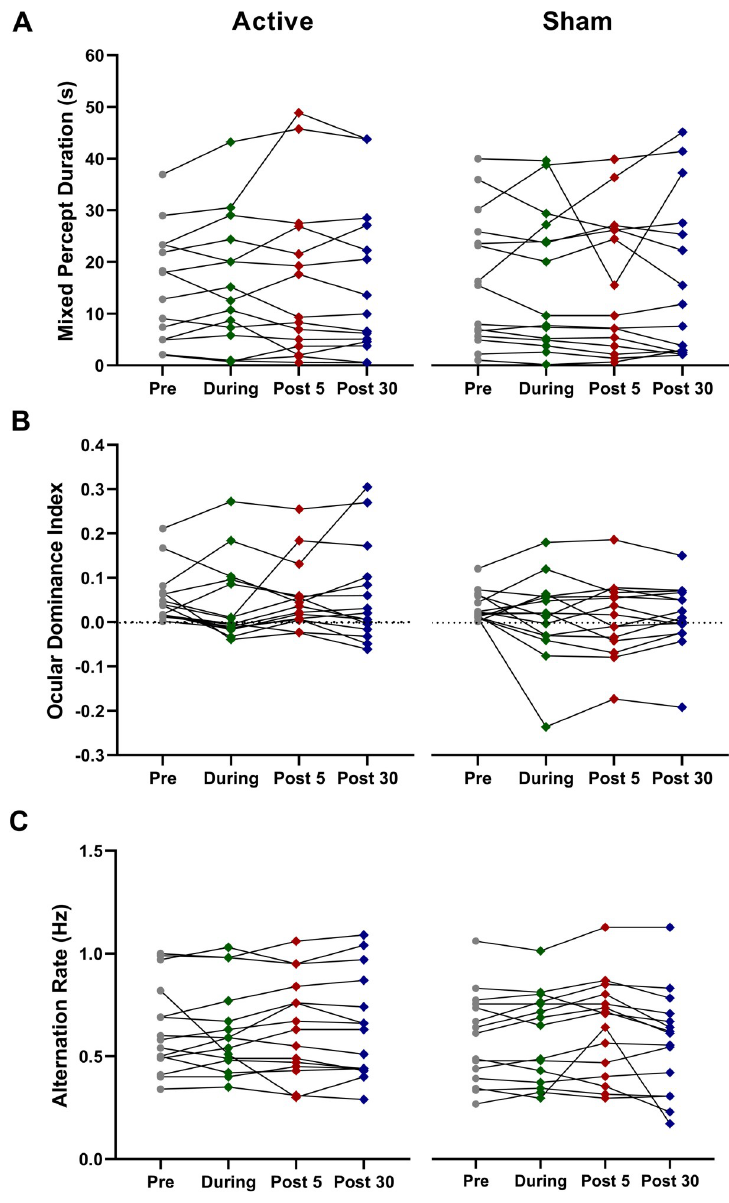
Fig 2. Average time spent in mixed percept (A), ocular dominance indices (B), and alternation rates (C) for 15 participants pre, during, 5 minutes and 30 minutes post a-tDCS. Error bars = SEM. No statistically significant effects were